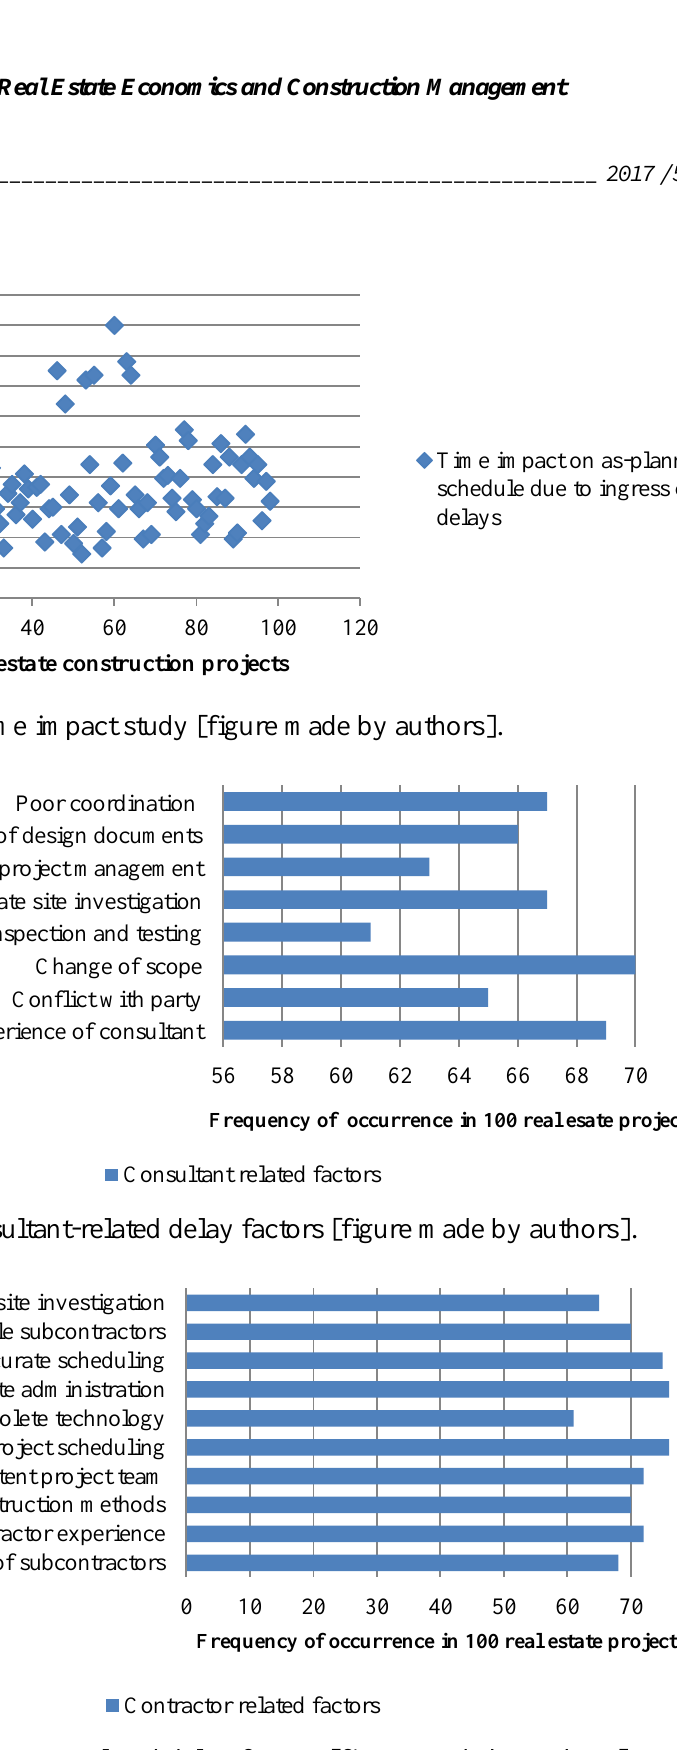
Fig. 4. Frequency of contractor-related delay factors [figure made by